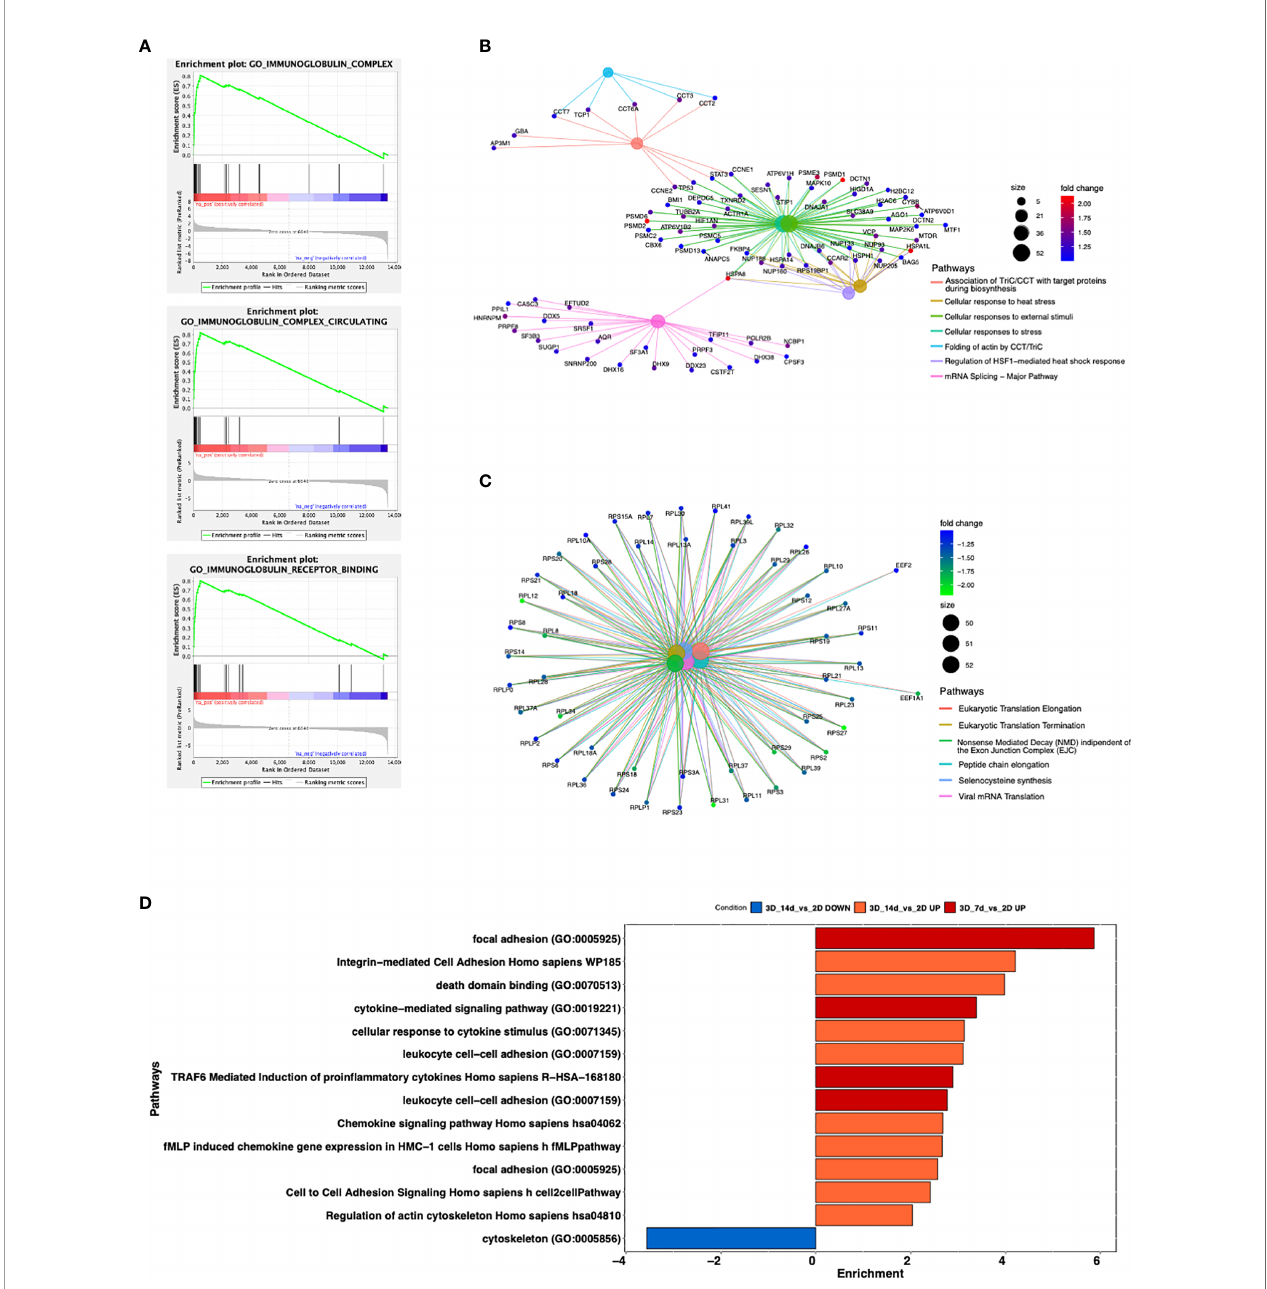
FIGURE 5 | Enrichment analysis of signi fi cantly modulated genes enriching different pathways. (A) GSEA curves for the fi rst most signi fi cantly up-regulated pathways for Gene Ontology database in the comparison 3D_7d_vs_2D. (B, C) Cnetplots highlighting up-regulated (B) and down-regulated (C) pathways between the comparisons 3D_7d_vs_2D. (D) Bar plot showing most modulated pathways in both comparisons 3D_7d_vs_2D and